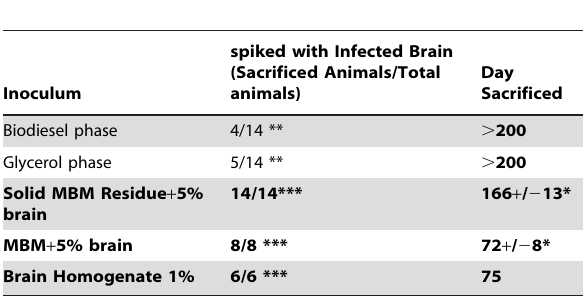
Table 3. Solid MBM Residue remains infectious after alkaline